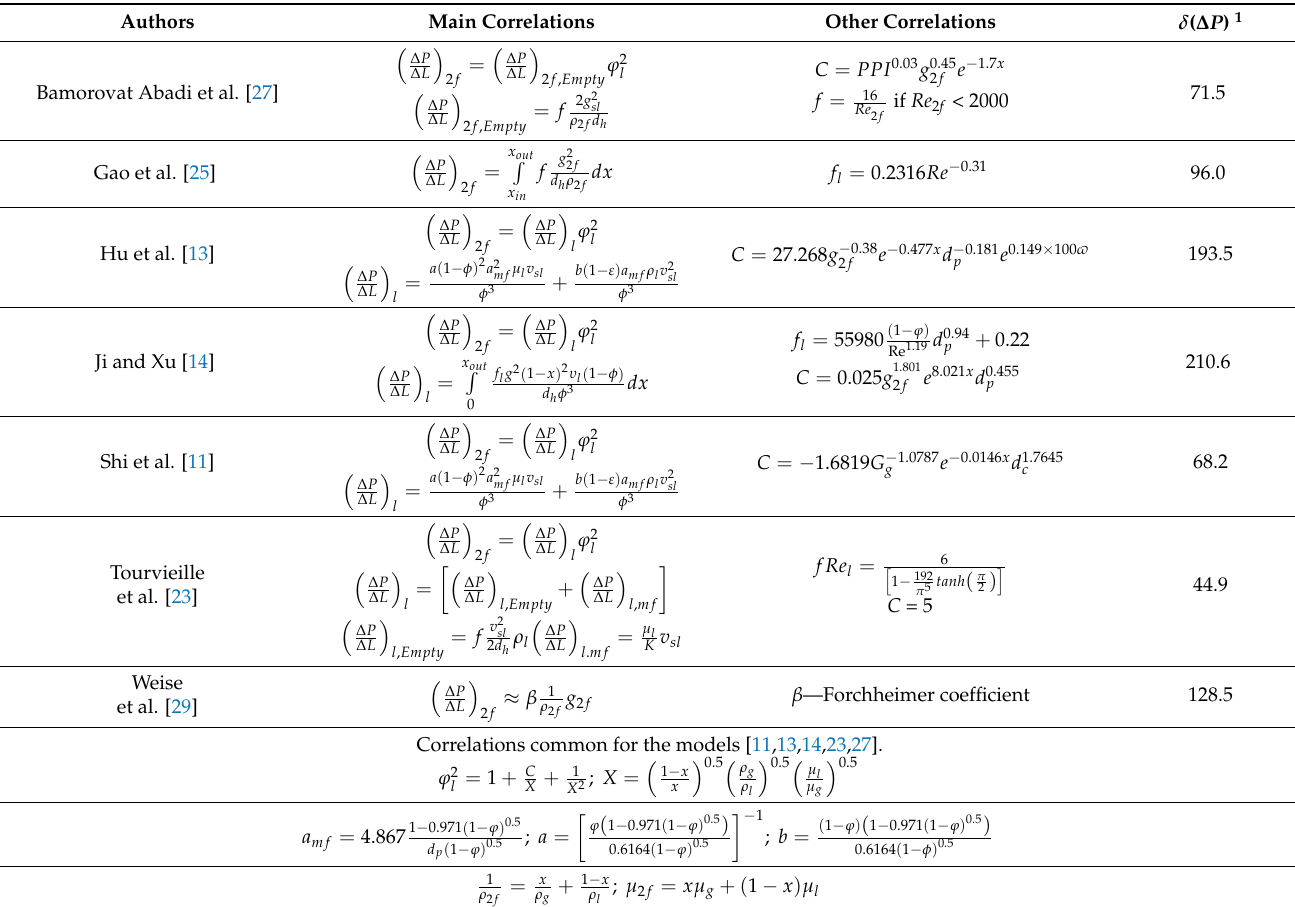
Table 6. Correlations describing the pressure drop of gas–liquid flow in channels with metal foam packing. Main Correlations Other Correlations